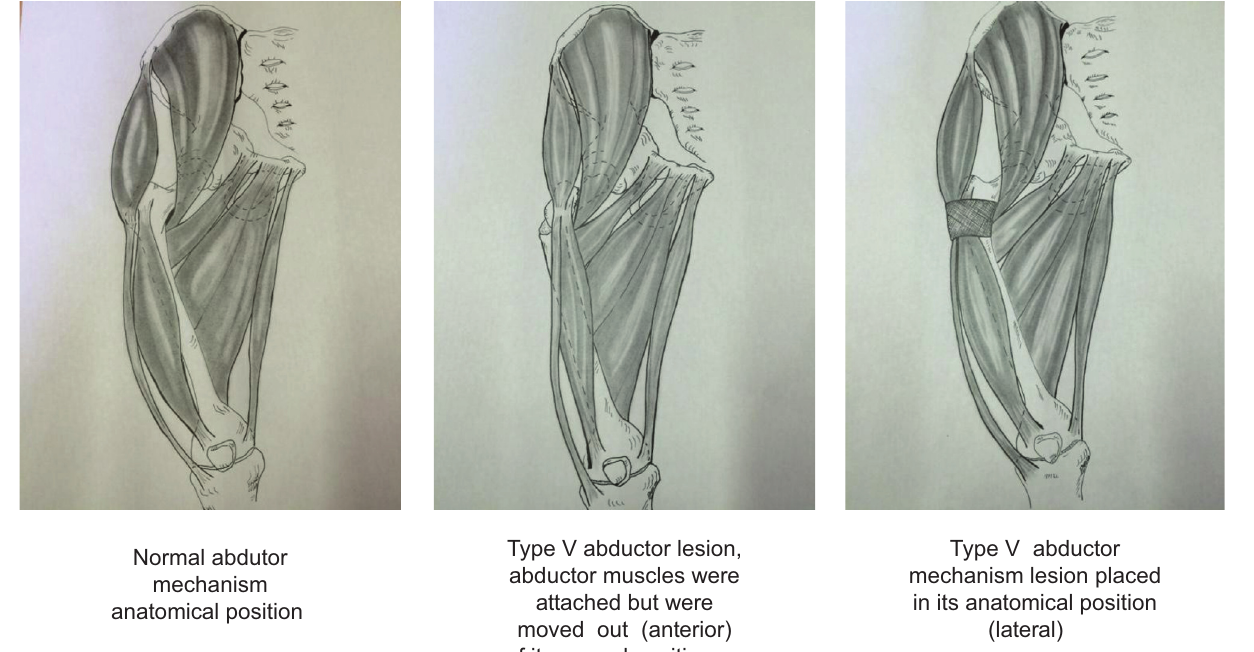
Figure 3. Type V abductor injury occurred when the abductor muscles were attached but were moved out of their normal position.